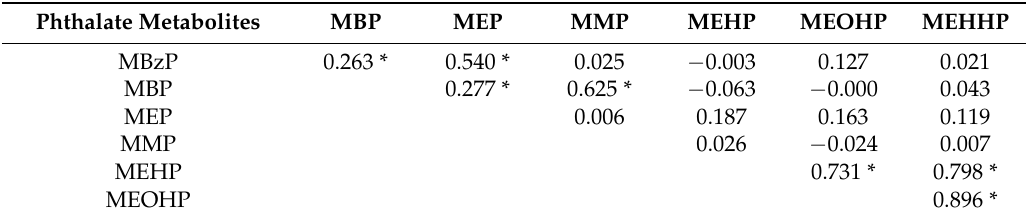
Table 4. Correlations between urinary phthalate metabolite concentrations in ( µ g/g creatinine) among the Iranian children and adolescents population ( n = 56).